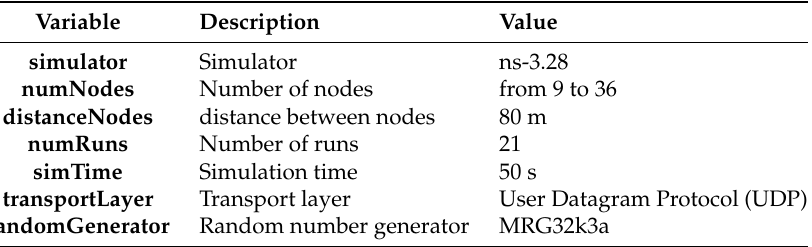
Table 3. General simulation parameters.